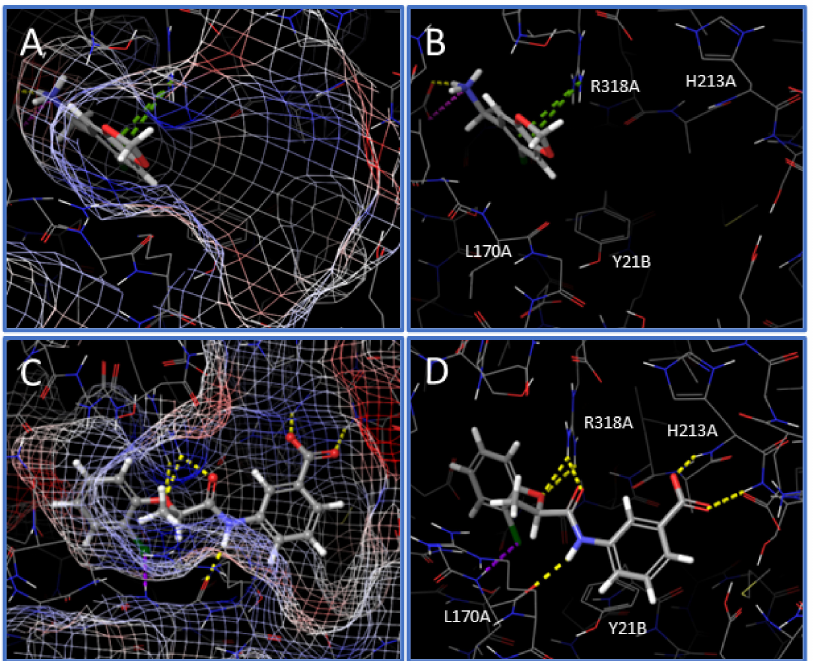
Figure 6. Binding mode that is predicted by molecular docking of compounds IM 29 ( A , B ) and IM 38 ( C , D ) in the hNAPRT active site. The analysis of the docking binding poses was performed on the academic version of Schrodinger Maestro v.2017-4. Protein is represented in thin sticks whereas ligands are depicted in thick tubes. Hydrogen bonds appear as yellow dotted lines. Salt bridges are represented by pink dotted lines. Pi-cation interactions are depicted as green dotted lines and halogen bonds are shown as purple dotted